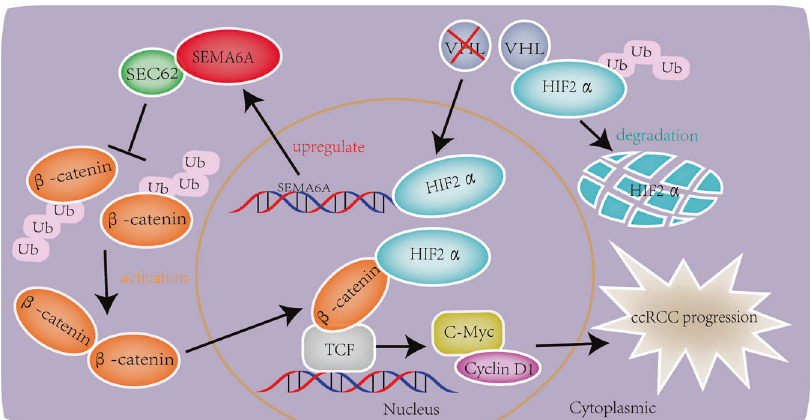
Fig. 7 Working model. In this working model, we showed that hypoxia-dependent HIF-2 α protein stabilization and activation-induced SEMA6A expression in ccRCC, which in turn bound to SEC62 protein to inhibit the ubiquitination and degradation of β -catenin, thereby promoting the expression of multiple tumor-promoting genes and tumor